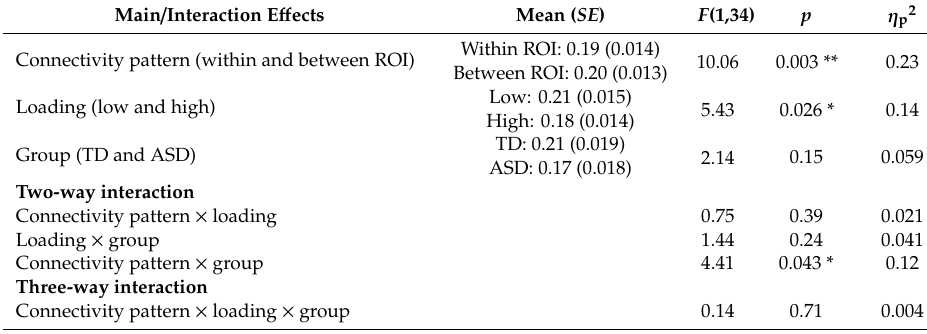
Table 5. Mixed ANOVA (group × loading × connectivity pattern) results for interhemispheric connectivity (i.e., mean